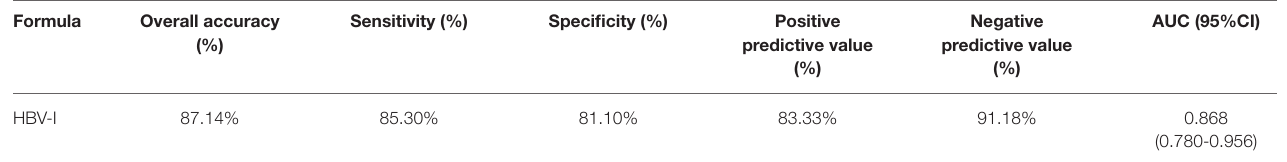
CBI, chronic HBV infection; NAFLD, nonalcoholic fatty liver disease; HBV-I, hepatitis B virus inflammation